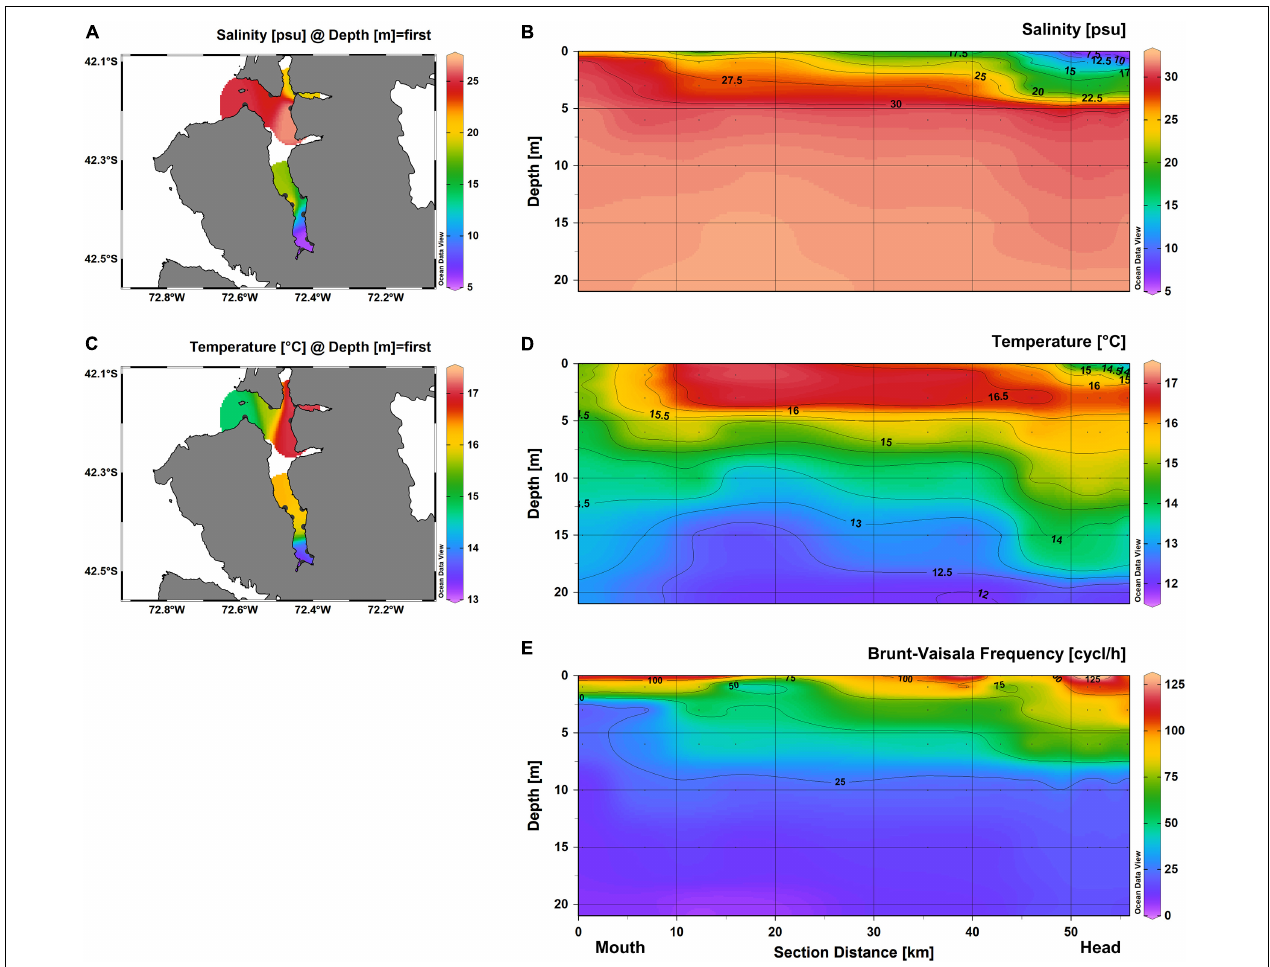
FIGURE 2 | Environmental variables distribution along Comau Fjord. CTD castings data showing (A) superficial and (B) longitudinal profile of temperature, (C) superficial and (D) longitudinal profile of salinity, and (E) longitudinal profile of Brunt-Väisälä frequency. All the physicochemical characteristics were measured during February 2020.